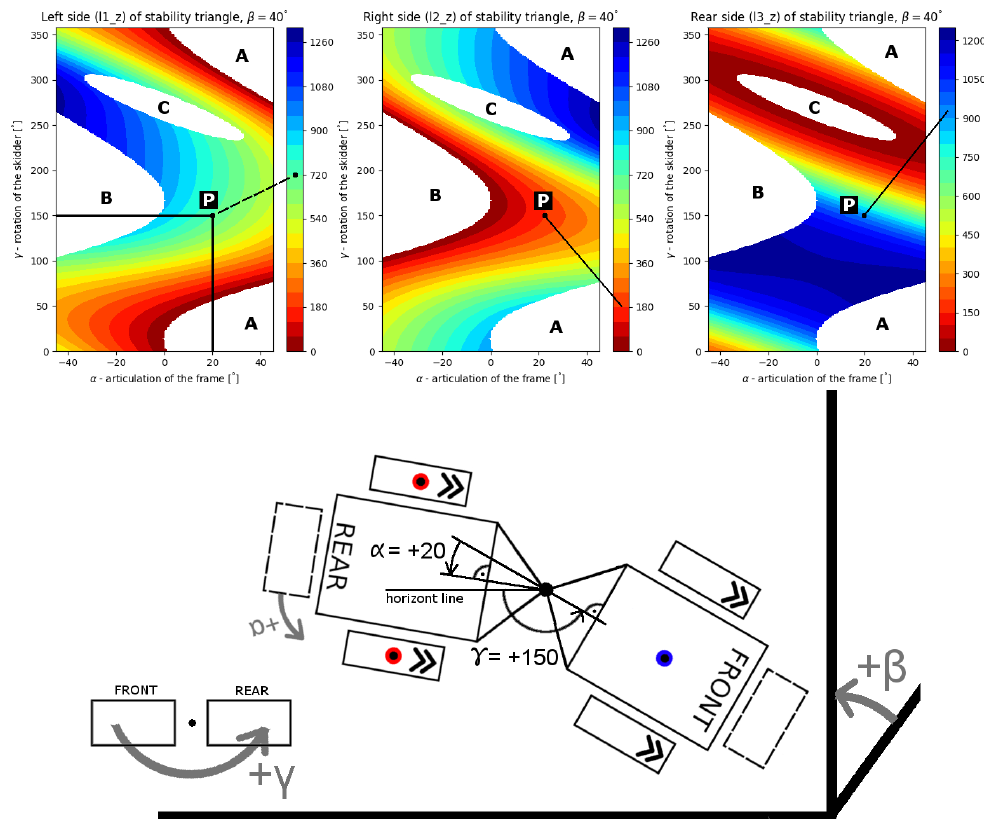
Figure 4. How to read the plots. Input parameters: α —articulation of frame, γ —rotation of skidder, γ —slope angle (constant value). P—a combination of input parameters, A—area of instability, due to the left side (tipping line) of stability triangle, B—area of instability, due to right side of stability triangle, C—area of instability, due to the rear side of stability triangle. The first and second images display lateral stability, and the last one stands for longitudinal stability. Color bars show the distance of the gravity vector (for the whole machine, including additional loads) to tipping lines in [mm].